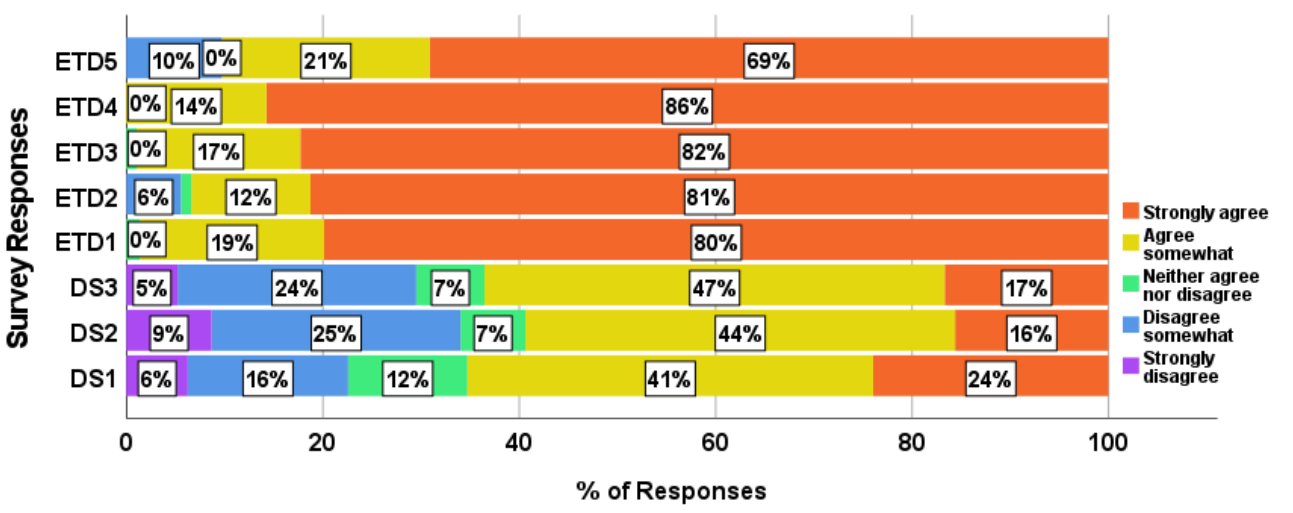
Figure 3. Distributions of the survey responses. ETD: Empathy toward the disabled, DS: Data security.